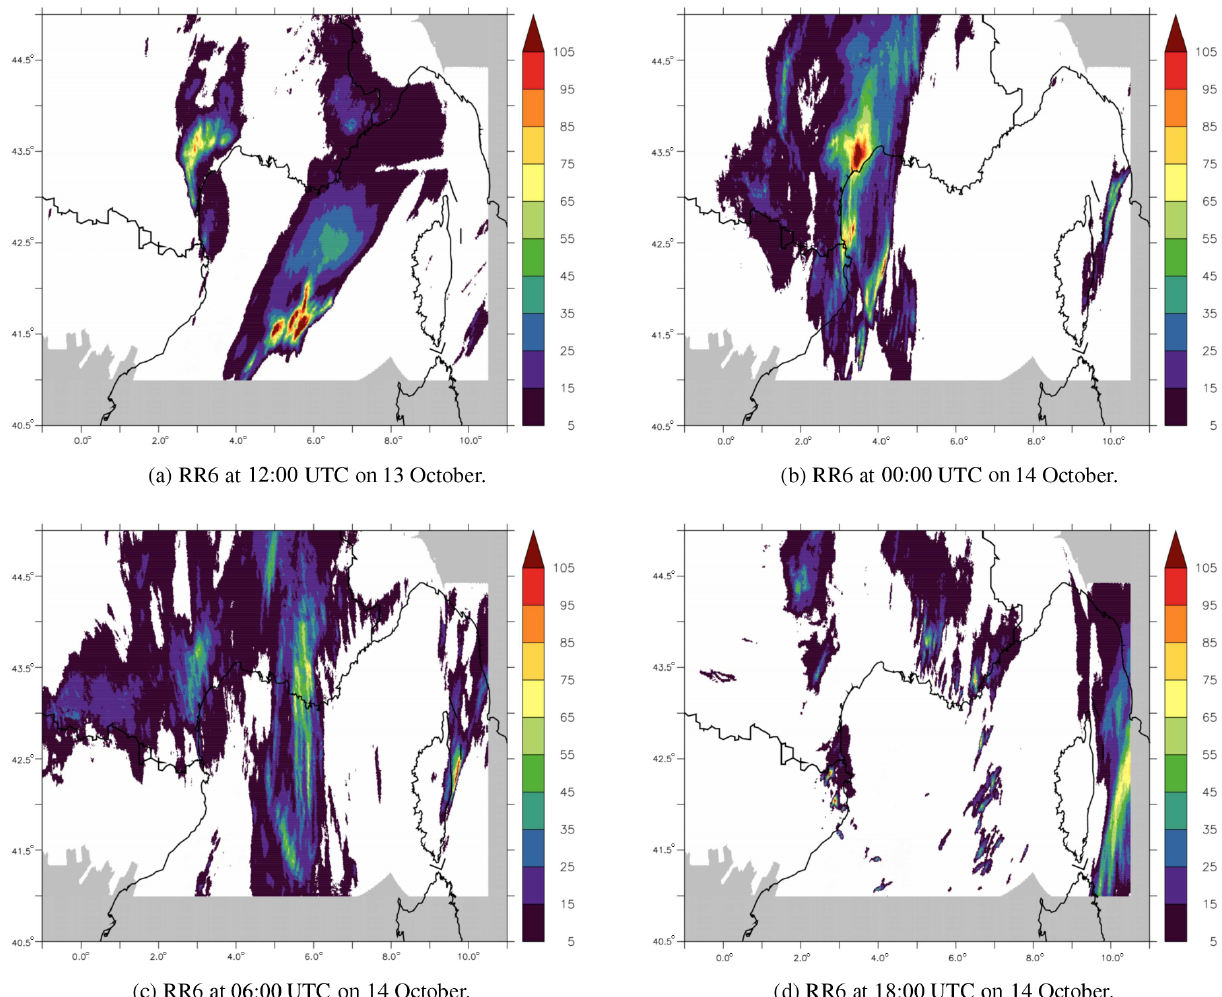
Figure 4. The 6h rainfall amounts (mm) from ANTILOPE